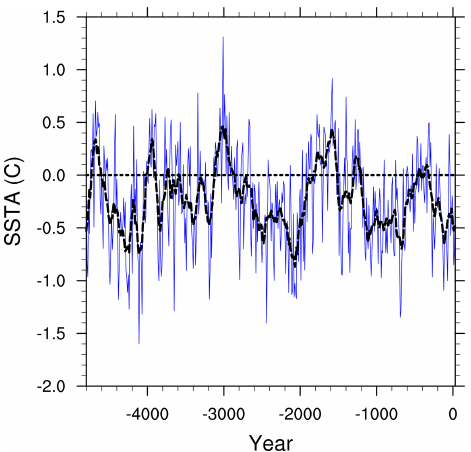
Figure 8. The 10-year running averaged (blue line) and 100-year running averaged (black line) SSTs in the area of the North Atlantic with significant negative SST differences between the 5th millen- niumBP and 9th millenniumBP periods (40–60 ◦ N, 7.5–60 ◦ W) in Fig. 2c, plotted as anomalies from the mean for 4800–4500BP; ∼ 69% of the time, temperatures in this region were below the